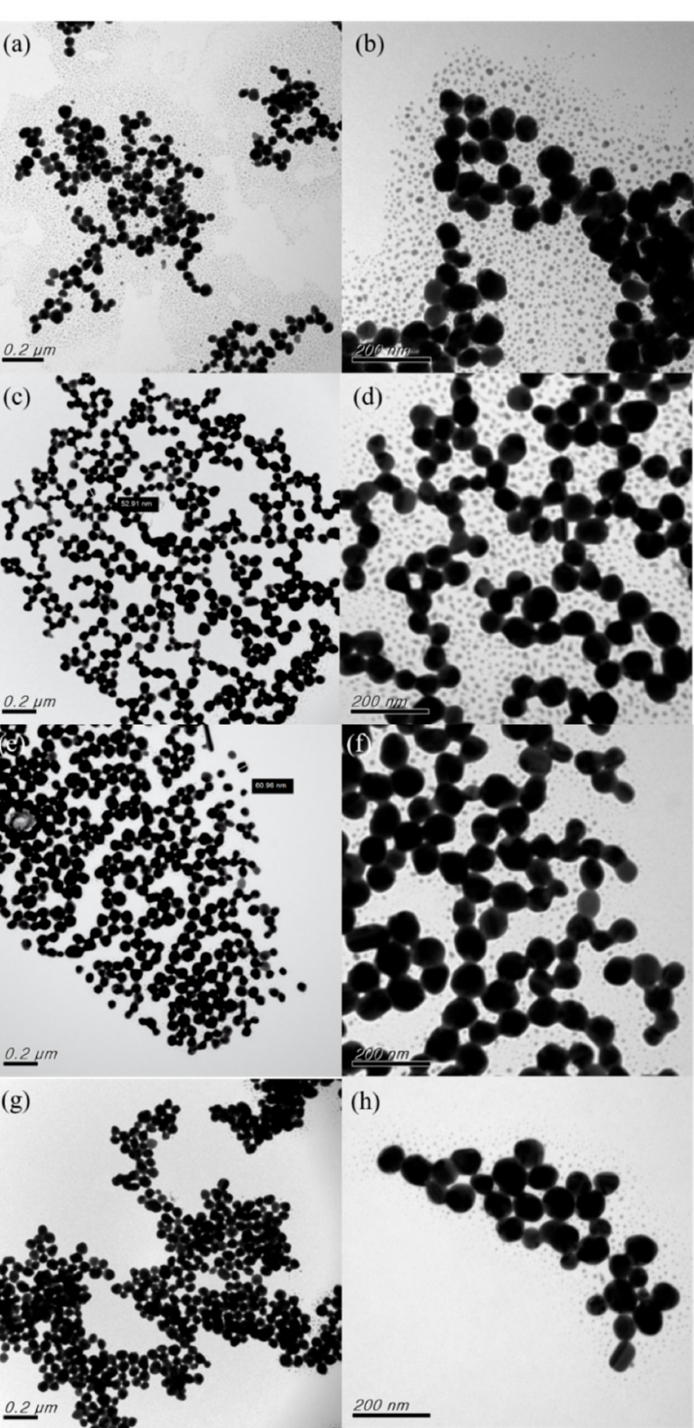
Figure 9. TEM images at two magnifications obtained for samples prepared with pH of: ( a , b ) 6; ( c , d ) 7; ( e , f ) 8; and ( g , h )